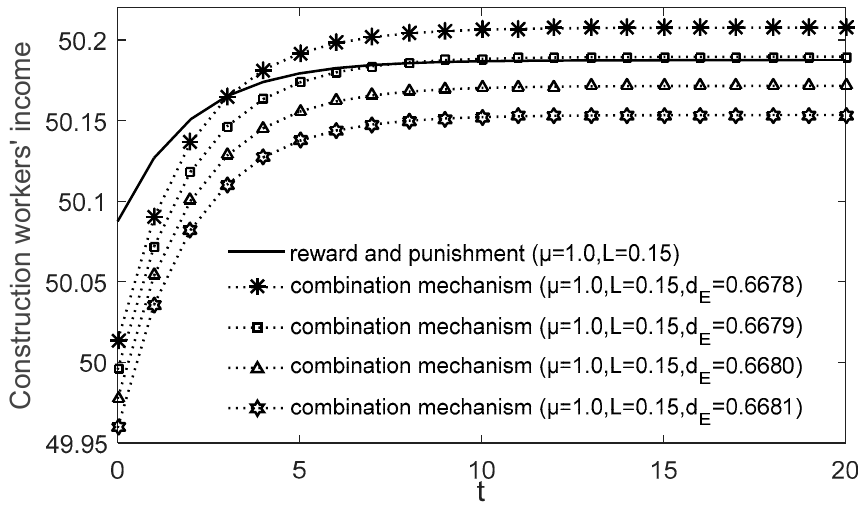
Figure 9. Construction workers’ income when d E takes different values under the combination mechanism.